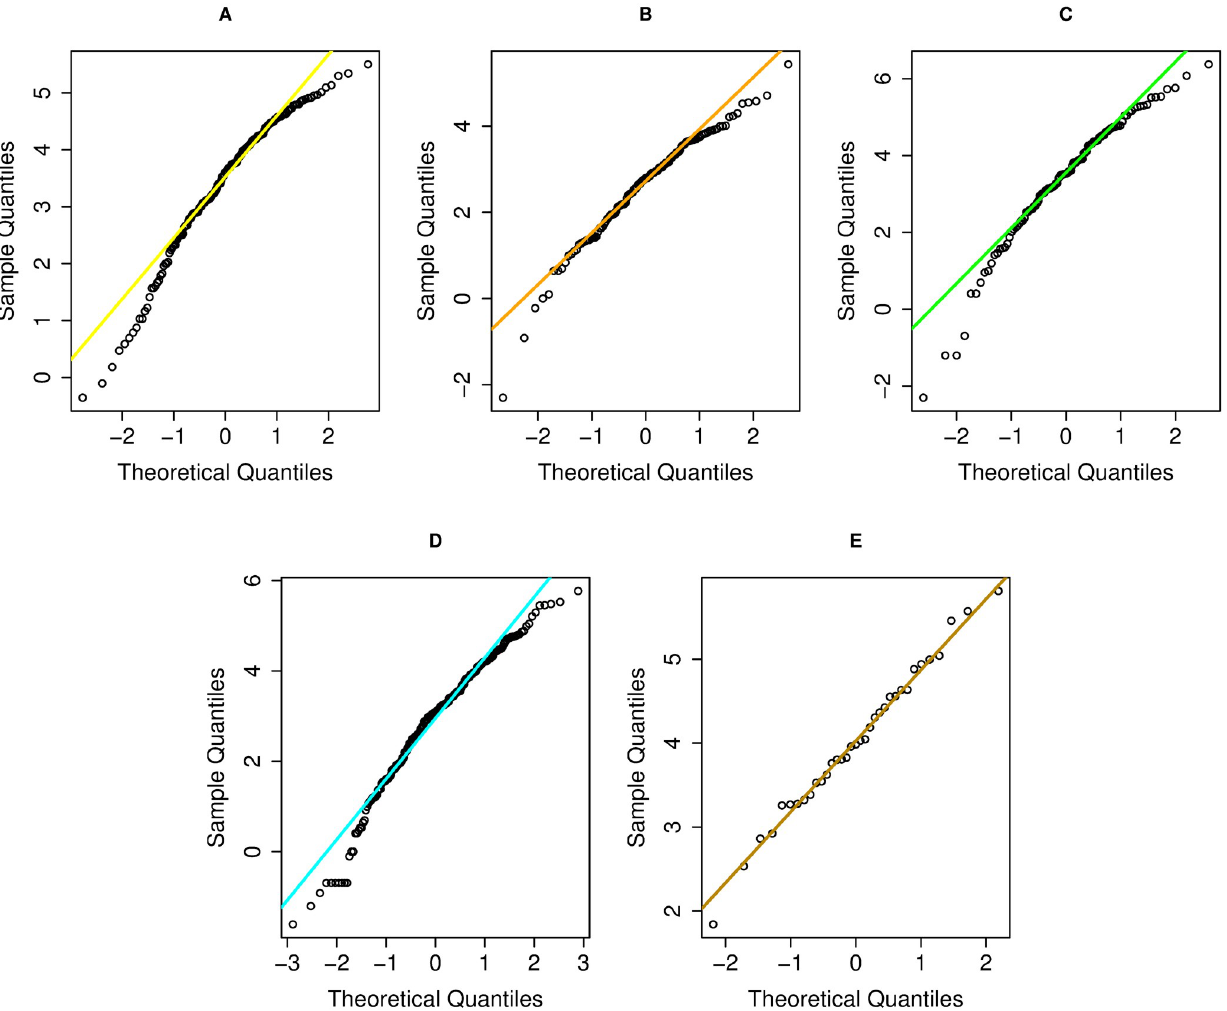
Fig 4. Normal Q-Q plots of log-transformation of non-zero records in five parts. (A) Northern (B) Central (C) Eastern (D) Southeastern (E) Southwestern.